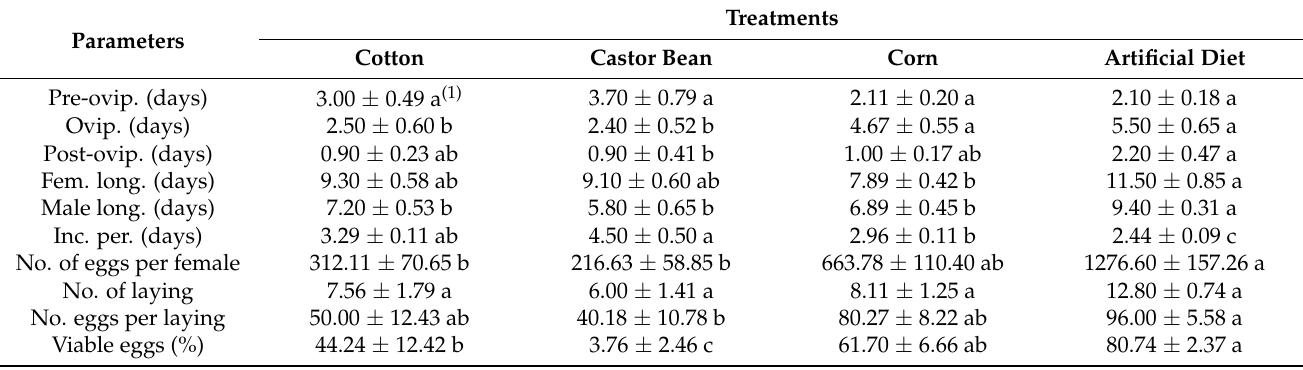
Table 5. Reproductive parameters (mean ± standard error) of Spodoptera frugiperda (Lepidoptera: Noctuidae) fed with pieces of cotton ( Gossypium hirsutum L.), castor bean ( Ricinus communis L.), corn ( Zea mays L.) leaves and an artificial diet at 25 ± 2 ◦ C, relative humidity of 60 ± 10 and photophase of 12